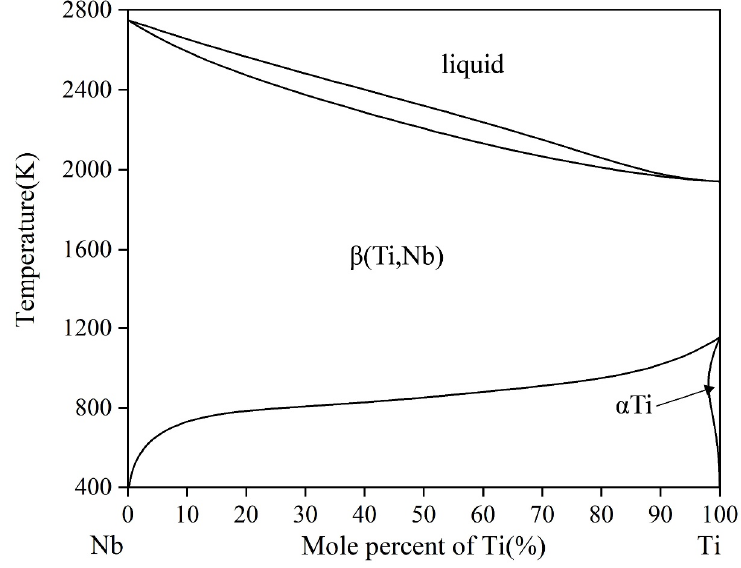
Figure 3. The calculated Ti-Nb phase diagram based on the work of Matsumoto et al. [27]. Table 1. Experimental and literature data on crystal structures and lattice parameters of the solid phases in Ti-Nb-Mn system. Phase